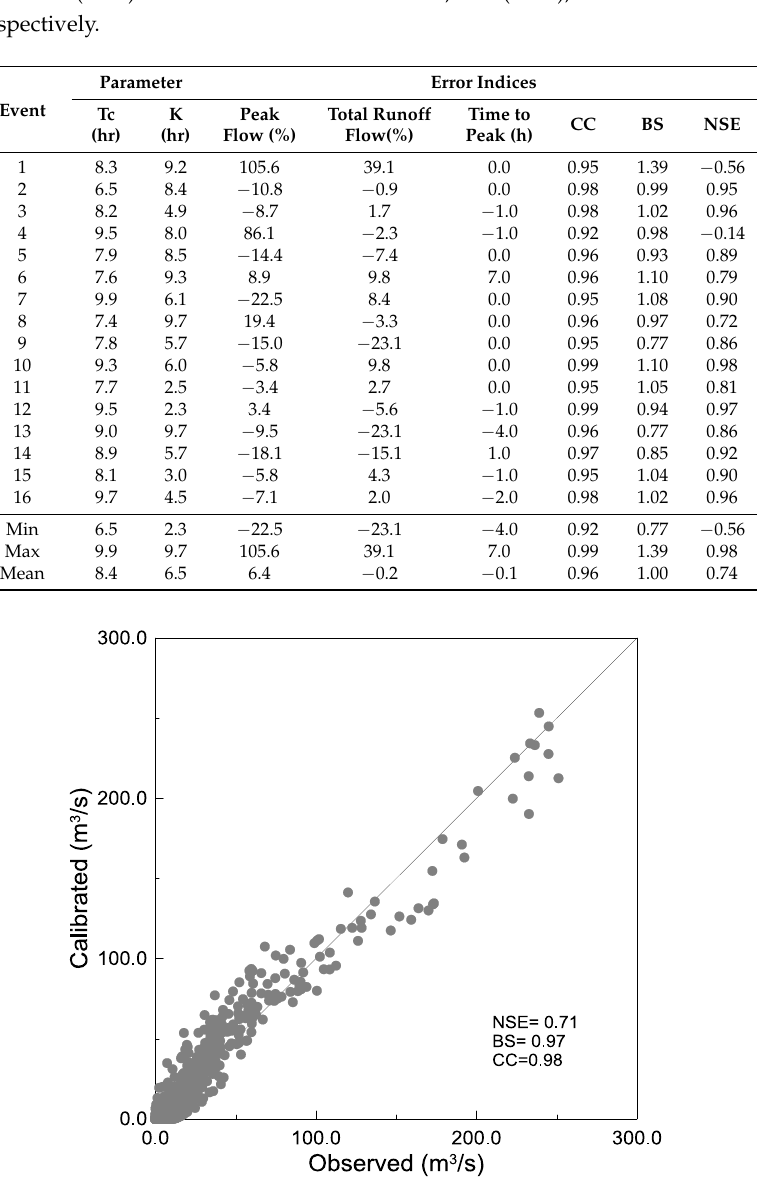
events generated three corresponding streamflow responses. The first event is used as a spin-up period and as a starting point of estimating direct runoff using the R-curve. The MRMS data was used as the